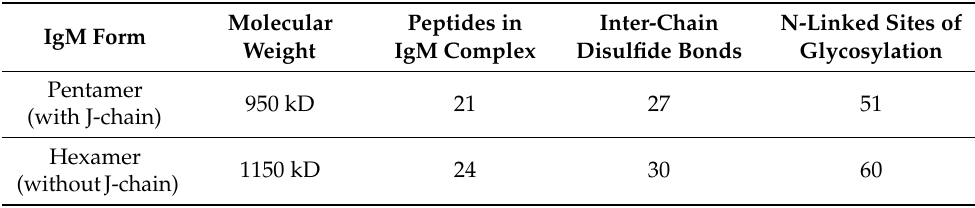
Table 1. IgM antibody